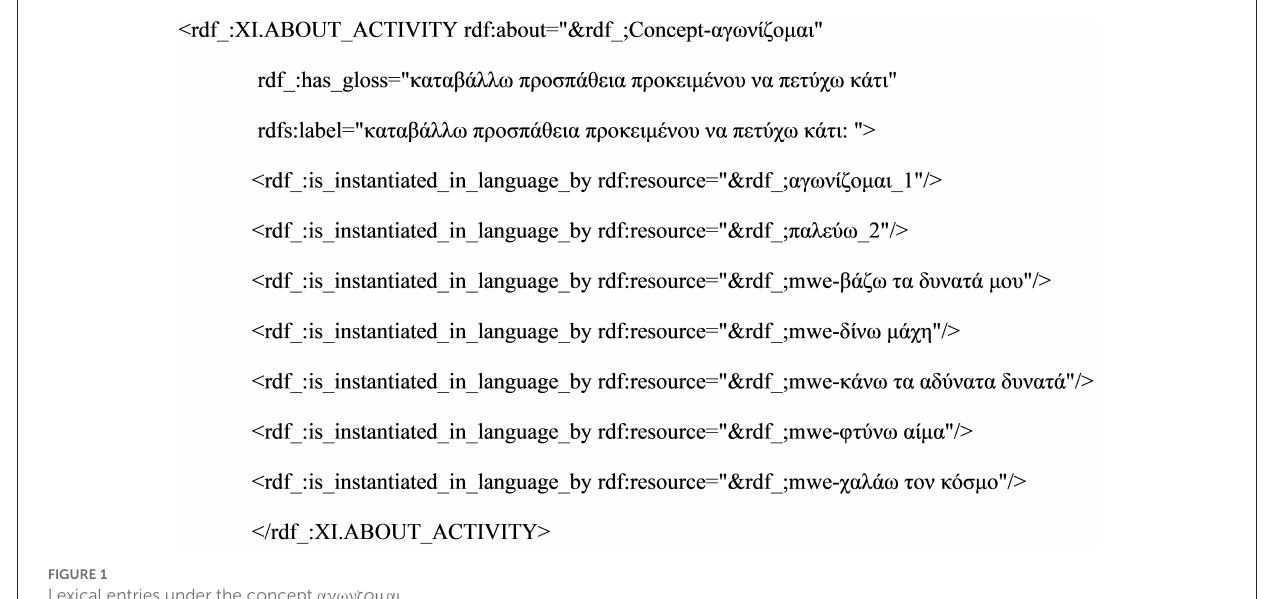
FIGURE1 Lexical entries under the concept αγωνζ o µαι